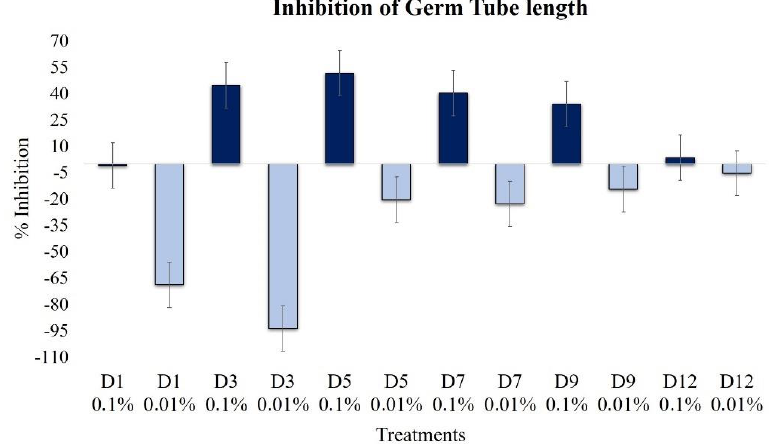
Figure 4. Effects of extracts at 0.1% (dark blue bars) and 0.01% (light blue bars) on the length of germ tubes of B. cinerea (1 × 10 5 conidia mL –1 , 14 h incubation, 100 rpm, 24 °C).